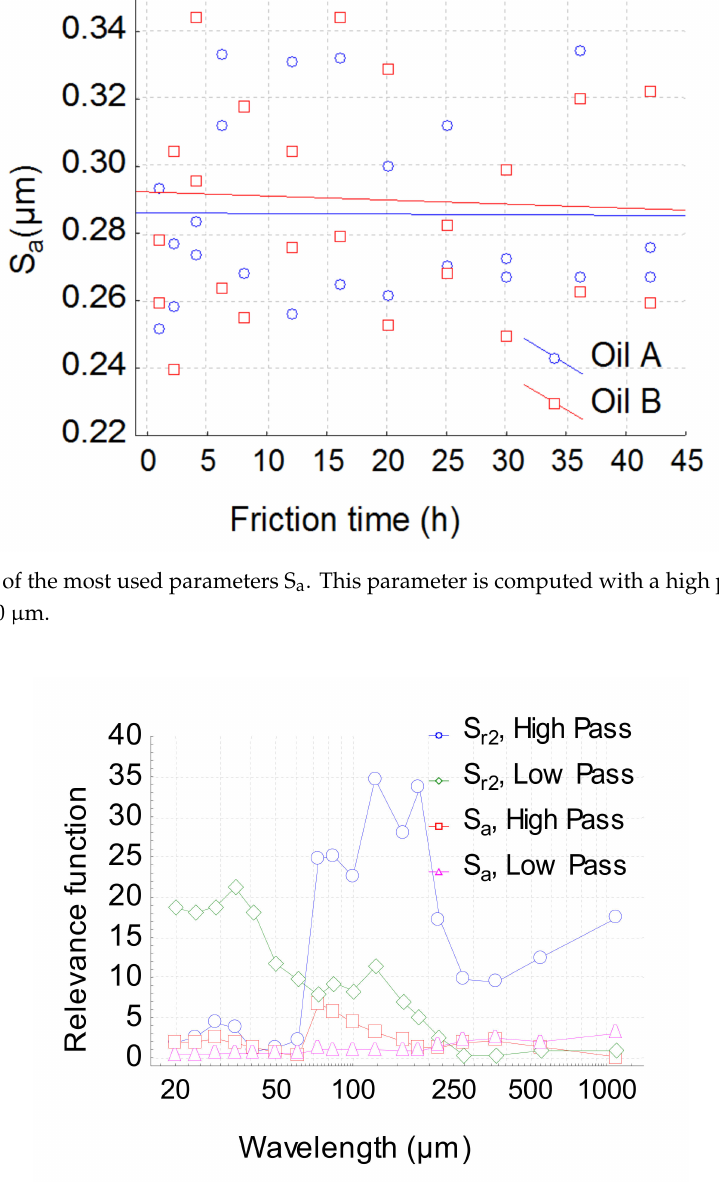
Figure 10. Plot of the relevance function F et S a